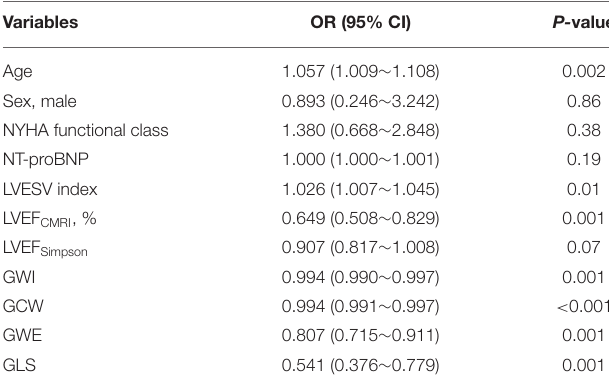
TABLE 4 | Univariate logistic regression analysis to identify the determinants of LV myocardial fibrosis at late gadolinium enhancement. Variables